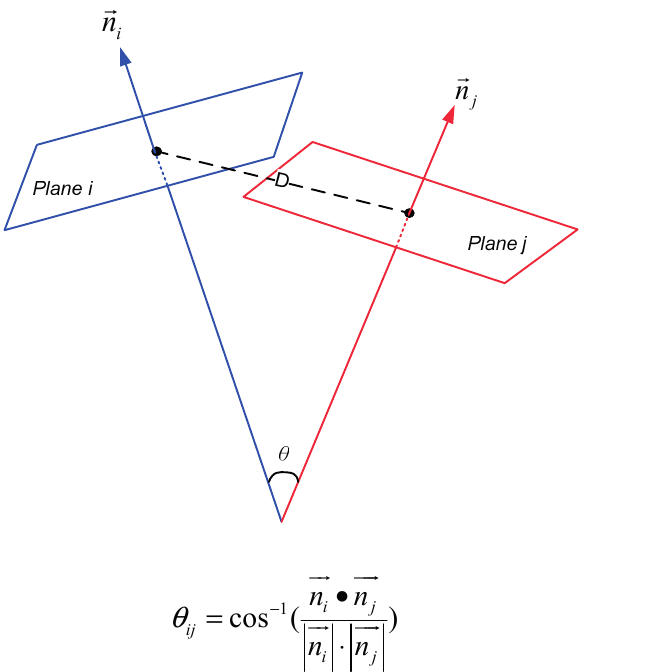
Figure 3. Illustration of angle and distance